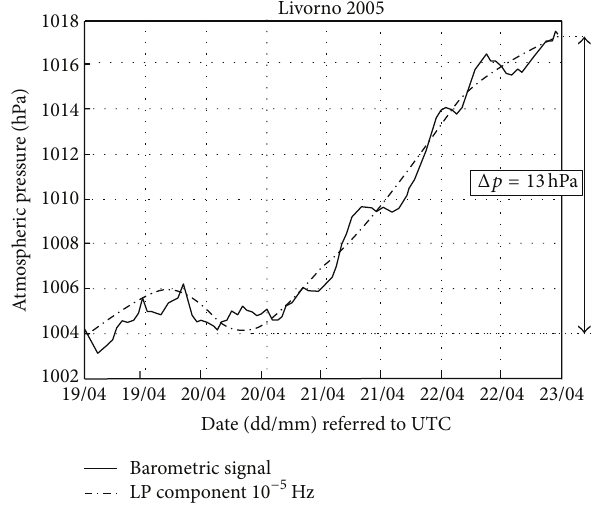
Figure 14: Atmospheric pressure variations in Port of Livorno (original signal and its low pass component in dotted line) (image from